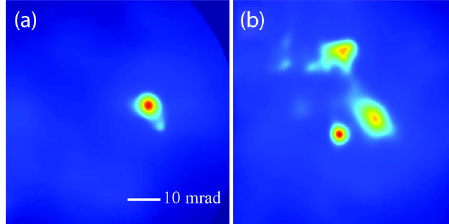
’ 8 : 5 (cid:8) 0 : 5 (cid:3) e ’ 6 : 5 (cid:8) 0 : 5 (cid:3) 10 19 cm (cid:4) 3 , e